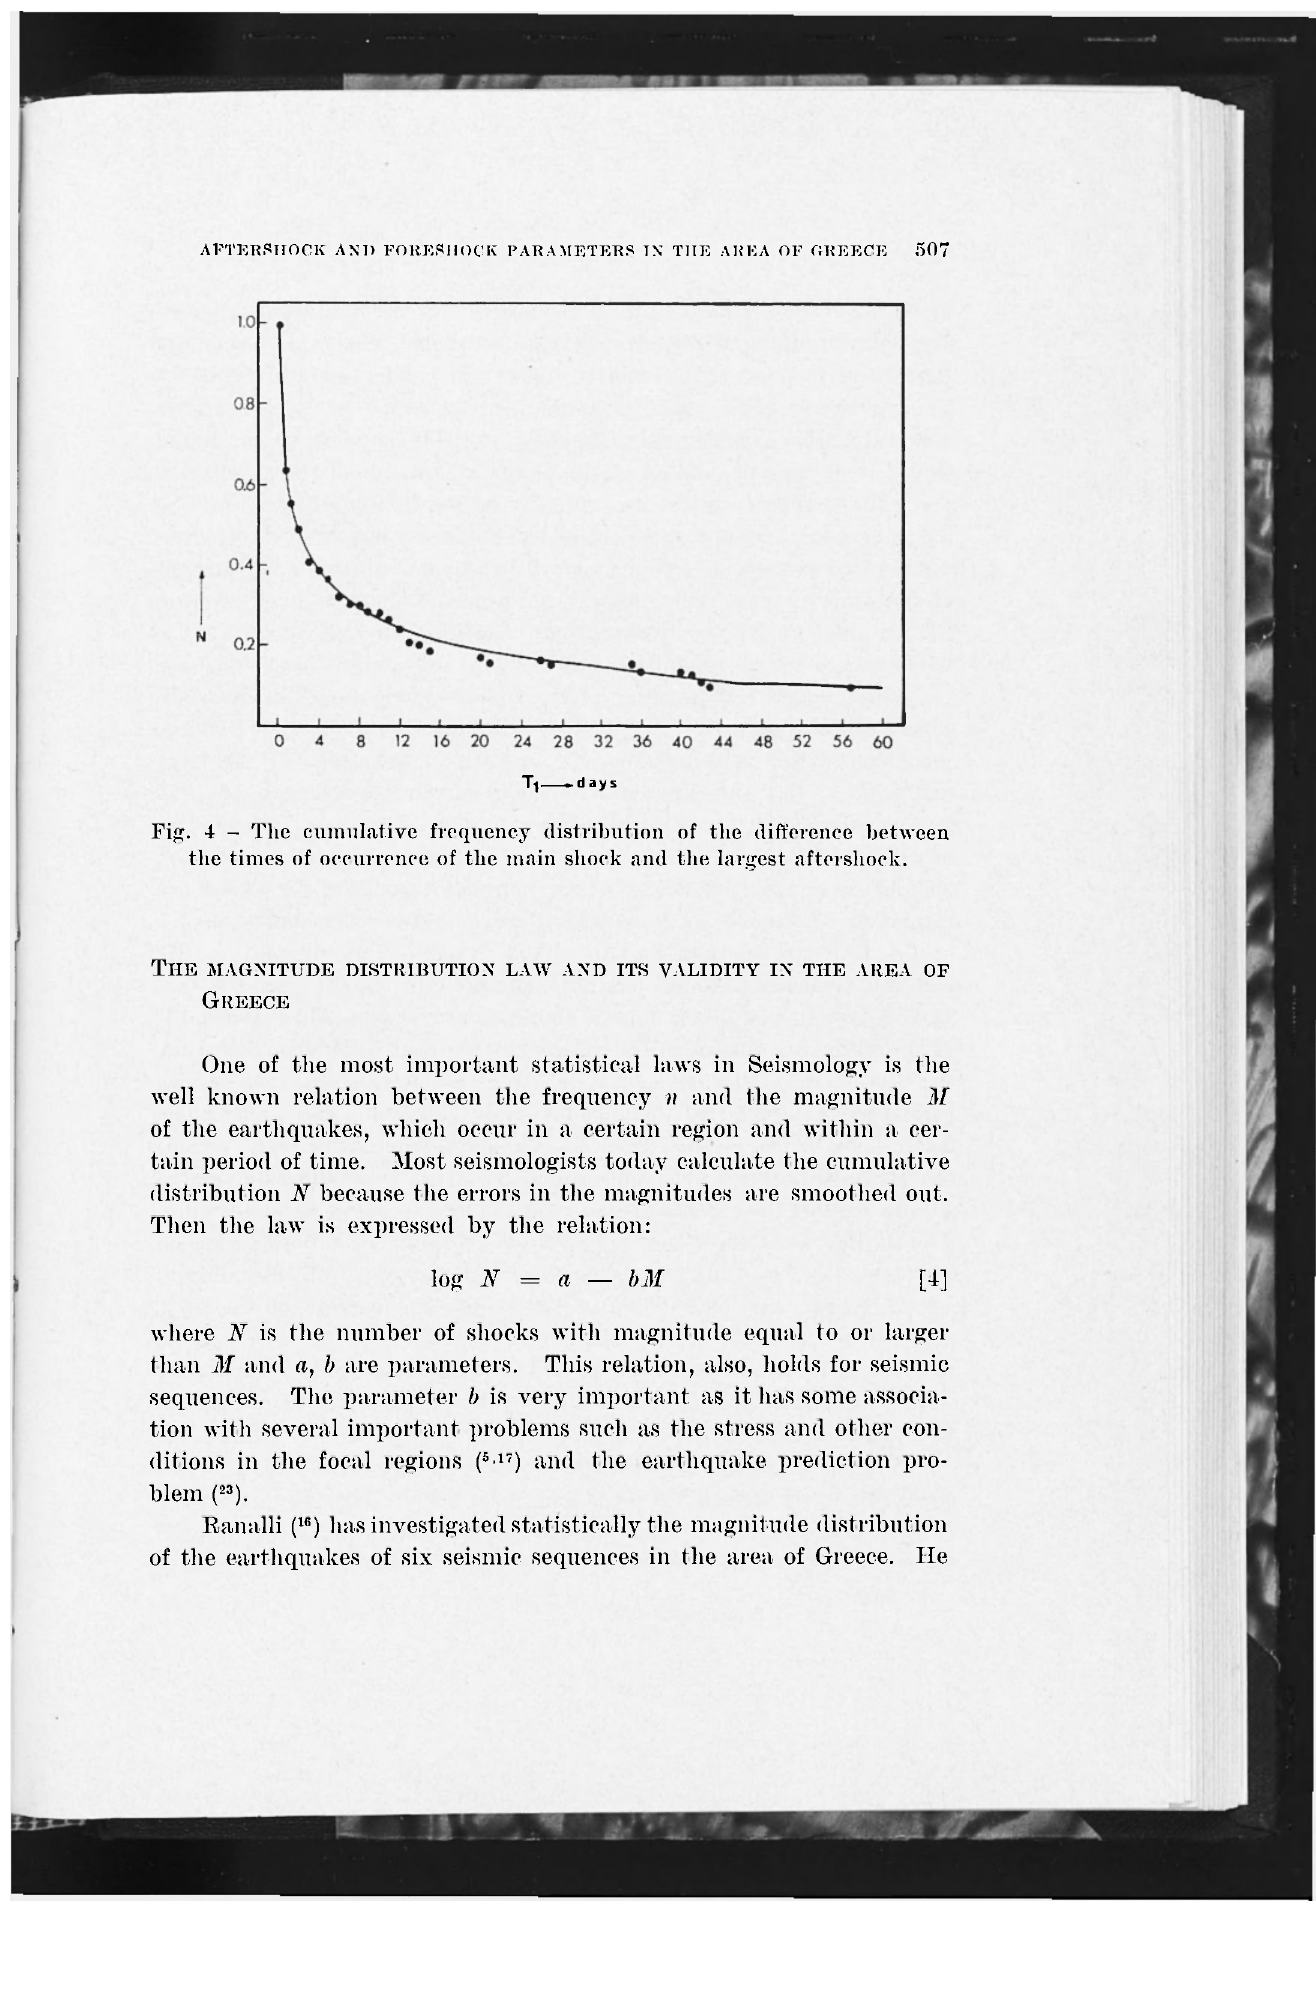
Fig. 4 - The cumulative frequency distribution of the difference between the times of occurrence of the main shock and the largest aftershock.